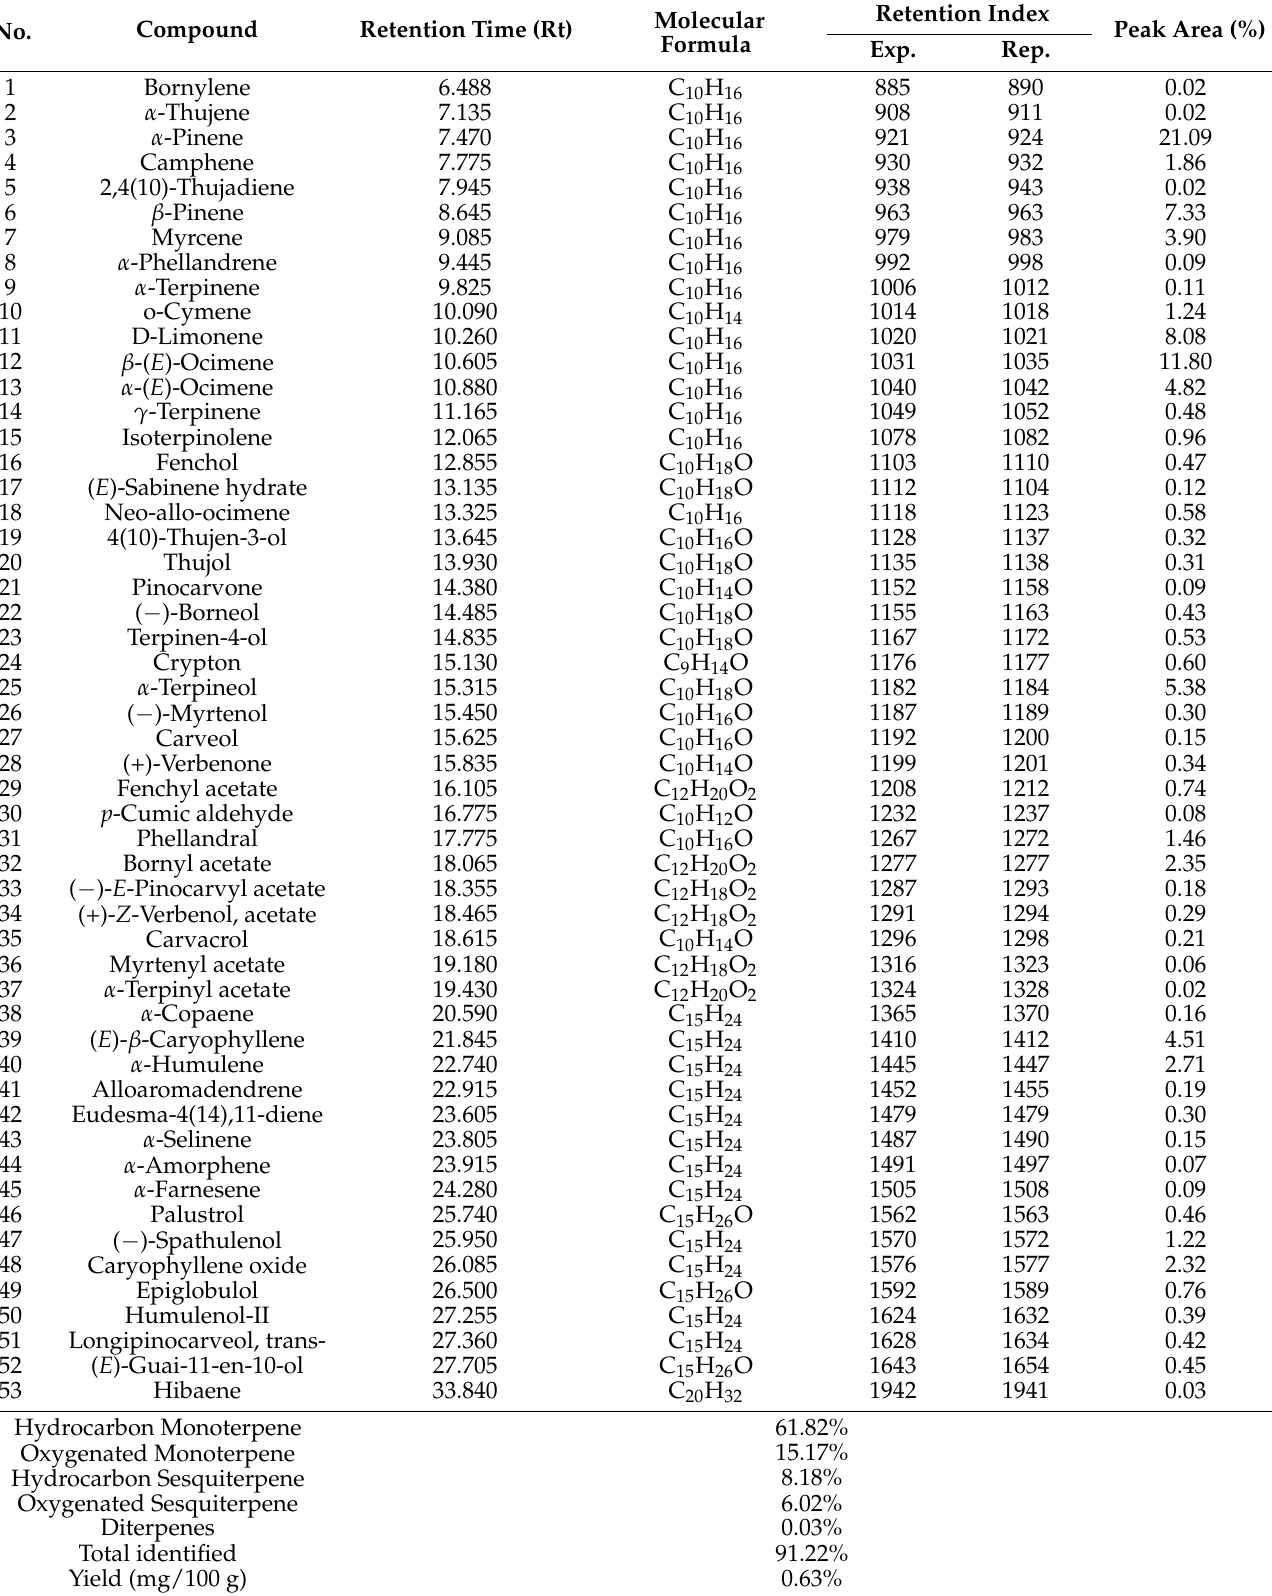
Table 1. Chemical composition (%) of essential oil identified from Syzigium cumini leaves grown in Egypt using GC/MS analysis. No.